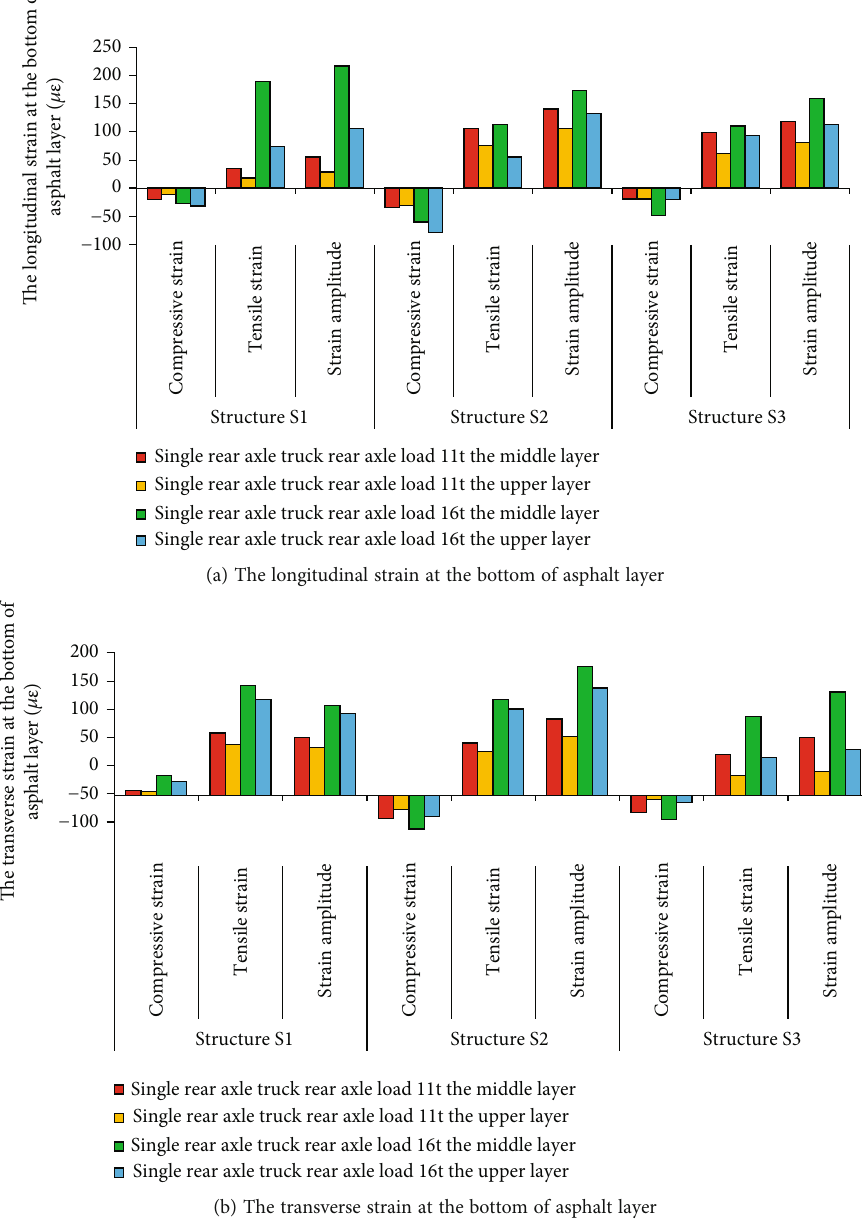
Single rear axle truck rear axle load 11t the middle layer Single rear axle truck rear axle load 11t the upper layer Single rear axle truck rear axle load 16t the middle layer Single rear axle truck rear axle load 16t the upper layer (b) The transverse strain at the bottom of asphalt layer Figure 11: